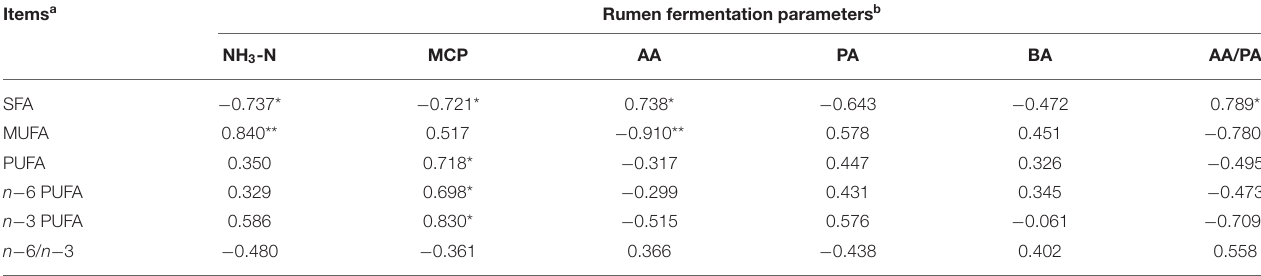
TABLE 6 | Correlation between rumen fermentation parameters and muscle fatty acids. Items a Rumen fermentation parameters b NH 3